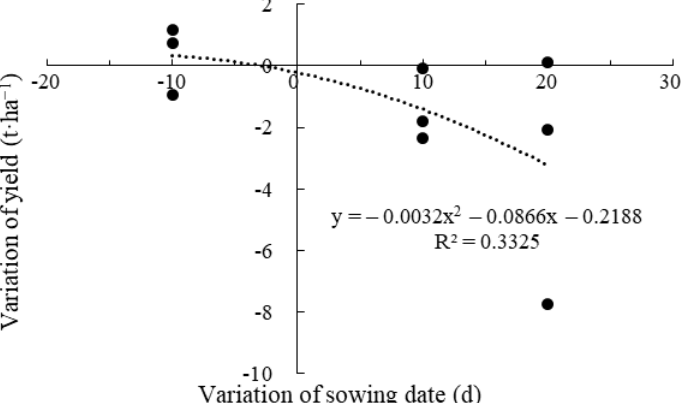
Figure 5. Effect of sowing date on winter wheat yield. Note: The horizontal coordinates represent the variation days in different sowing dates relative to the normal sowing date, and the vertical coordinates represent the variation in yield amount in different sowing dates relative to the normal sowing date. The black dotted lines represent the fitted regression trend line.